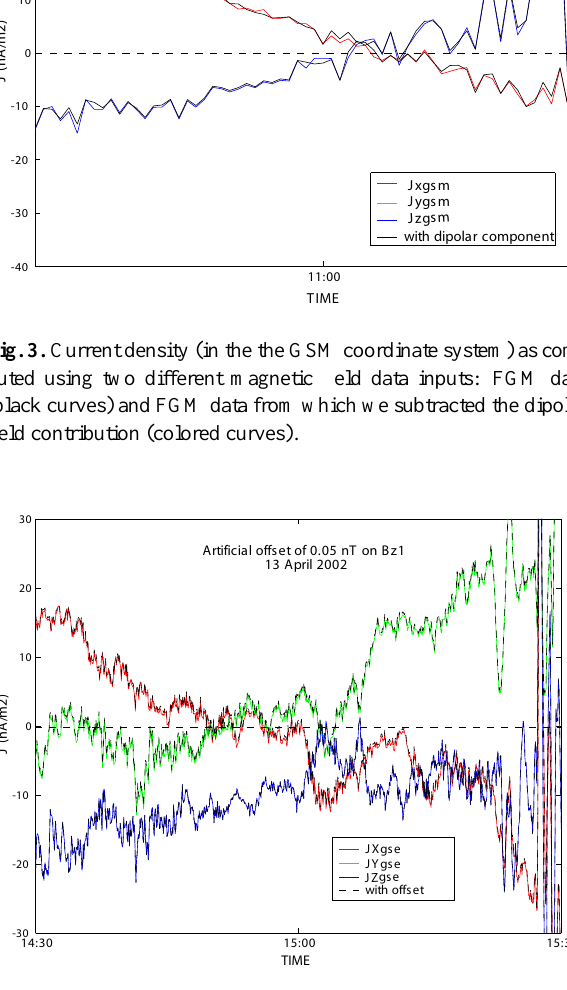
Fig. 4. Current density (in the GSE coordinate system) as computed using two different magnetic field data inputs: FGM data (colored curves) and FGM data to which we added an artificial offset of 0.05nT on the B z component (on SC1, black dashed curves).